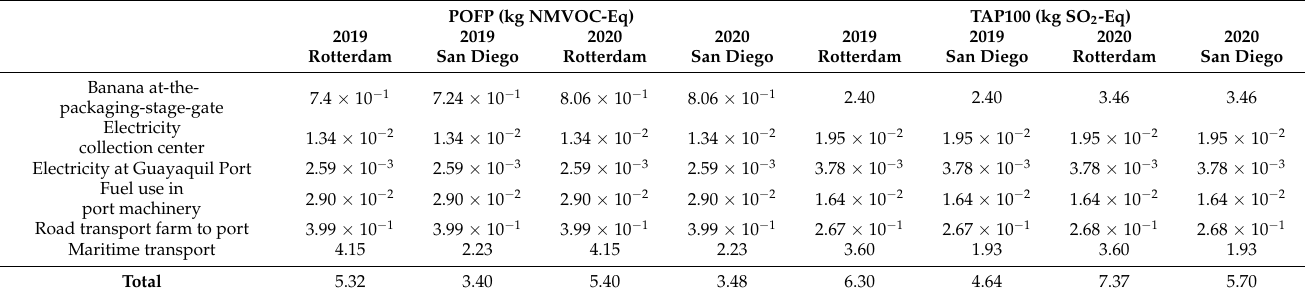
Table 8. Impact category indicator results for 1 ton of “Banana at-the-foreign-port” for years 2019 and 2020 by impact categories POFP and TAP100.